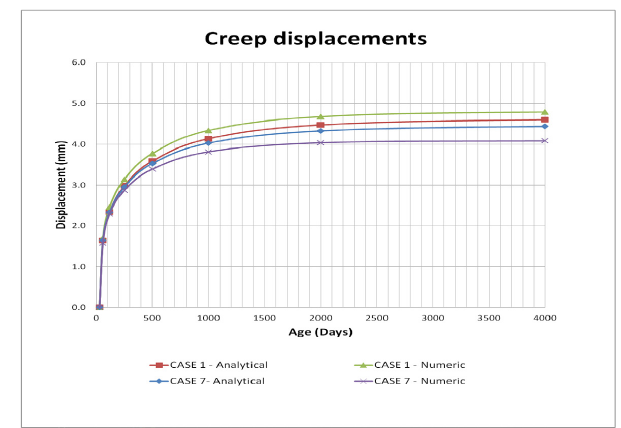
Figure 5. Creep displacements by time